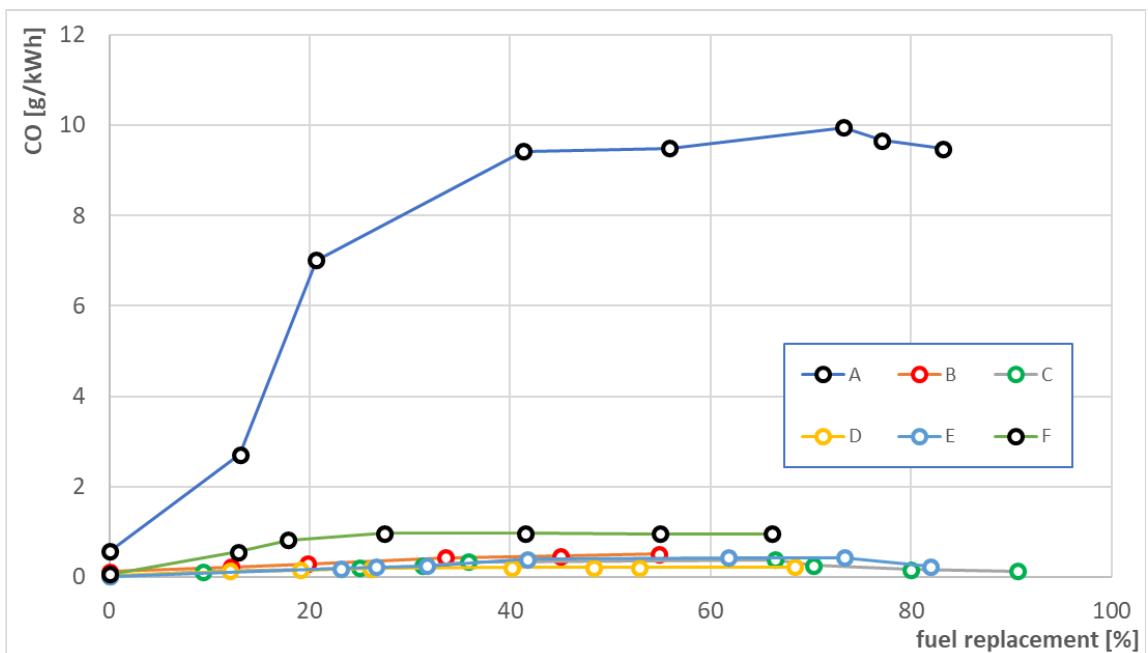
Figure 3. Curves from A to F showing engine’s emission of CO (carbon monoxide) for individual engine operating points, where the rotation speed, power, and torque were constant, as a replacement function of diesel fuel replaced by CNG.